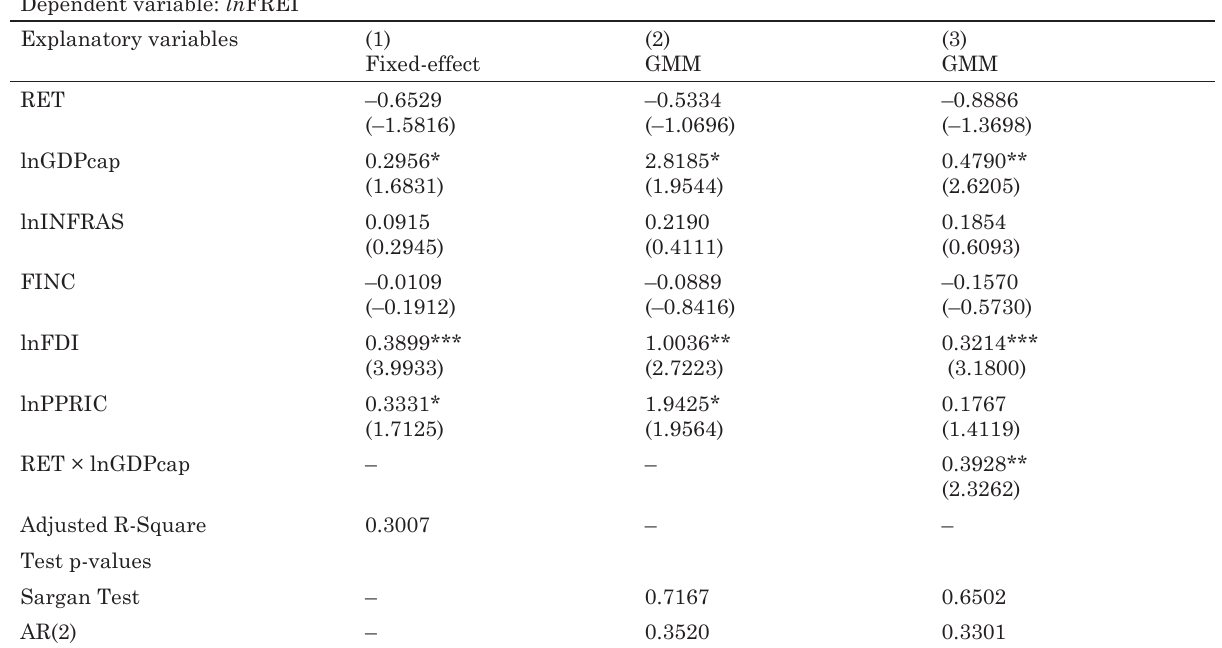
Table 3. Regression